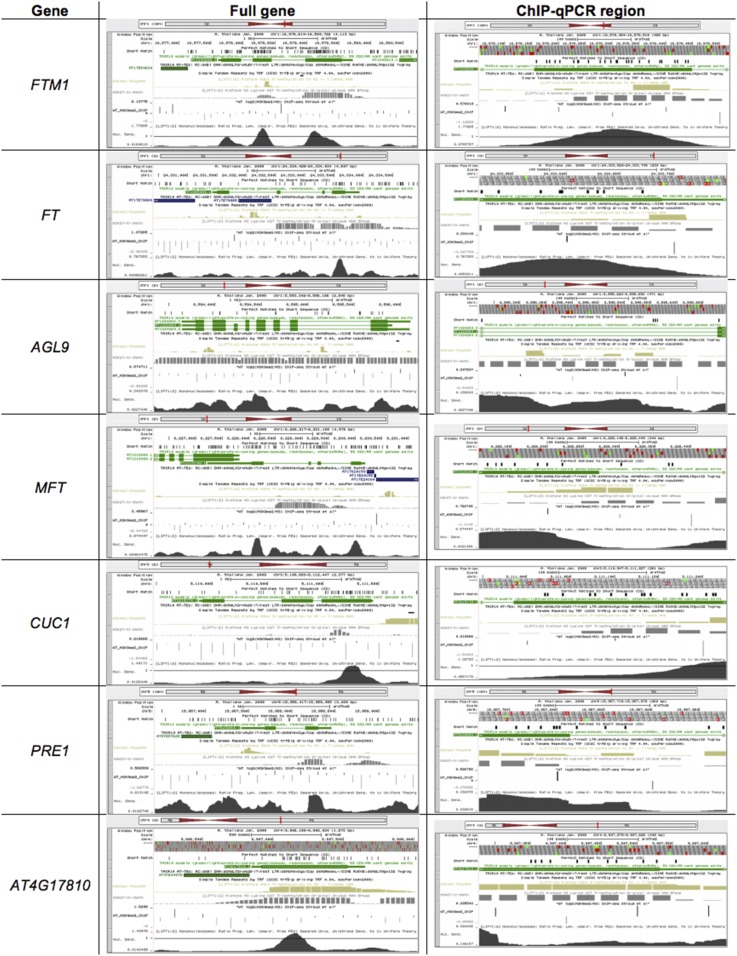
DOI:
http://dx.doi.org/10.7554/eLife.06671.031